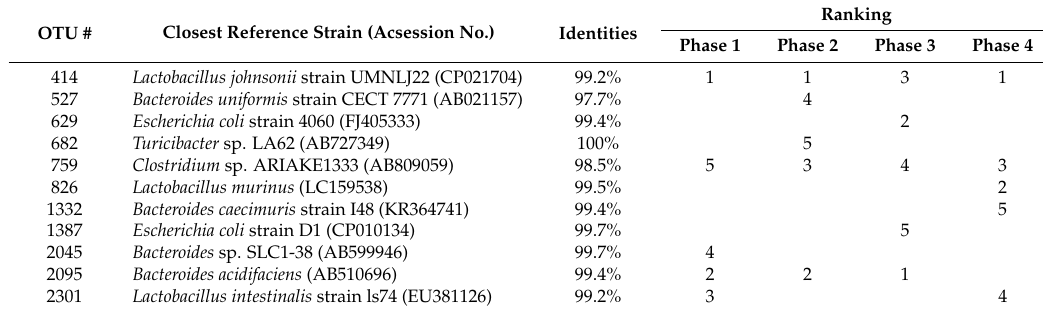
Table 1. List of the top five most abundant operational taxonomic units (OTUs) in each phase. Taxonomic assignment of eleven OTUs was carried out with the basic local alignment search tool (BLAST) program in the DNA Data Bank of Japan (DDBJ) nucleotide sequence database. Ranking OTU # Closest Reference Strain (Acsession No.) Identities Phase 1 Phase 2 Phase 3 Phase 4 414 Lactobacillus johnsonii strain UMNLJ22 (CP021704) 99.2% 1 1 3 1 527 Bacteroides uniformis strain CECT 7771 (AB021157) 97.7% 4 629 Escherichia coli strain 4060 (FJ405333) 99.4% 2 682 Turicibacter sp. LA62 (AB727349) 100% 5 759 Clostridium sp. ARIAKE1333 (AB809059) 98.5% 5 3 4 3 826 Lactobacillus murinus (LC159538) 99.5% 2 1332 Bacteroides caecimuris strain I48 (KR364741) 99.4% 5 1387 Escherichia coli strain D1 (CP010134) 99.7% 5 2045 Bacteroides sp. SLC1-38 (AB599946) 99.7% 4 2095 Bacteroides acidifaciens (AB510696) 99.4% 2 2 1 2301 Lactobacillus intestinalis strain ls74 (EU381126) 99.2% 3